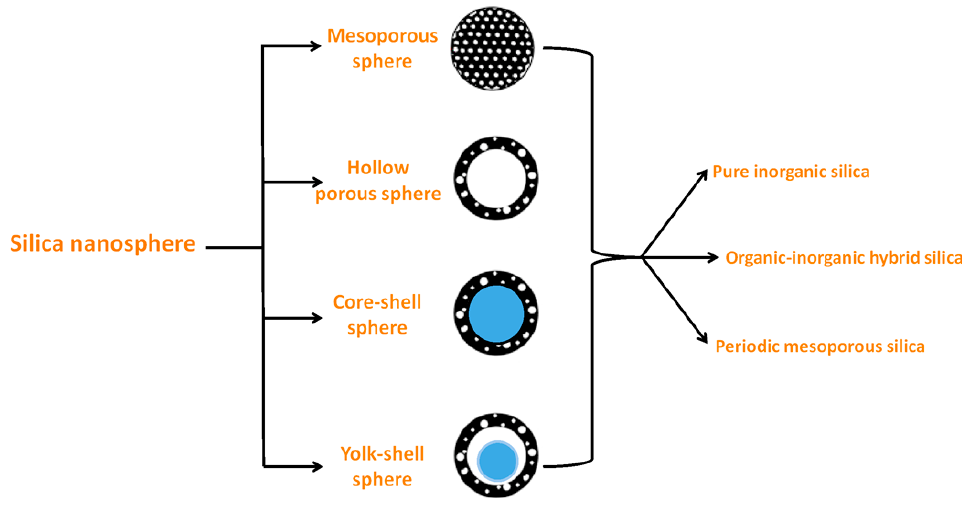
Figure 2. General synthesis strategy for mesoporous silica using a surfactant-templated route.